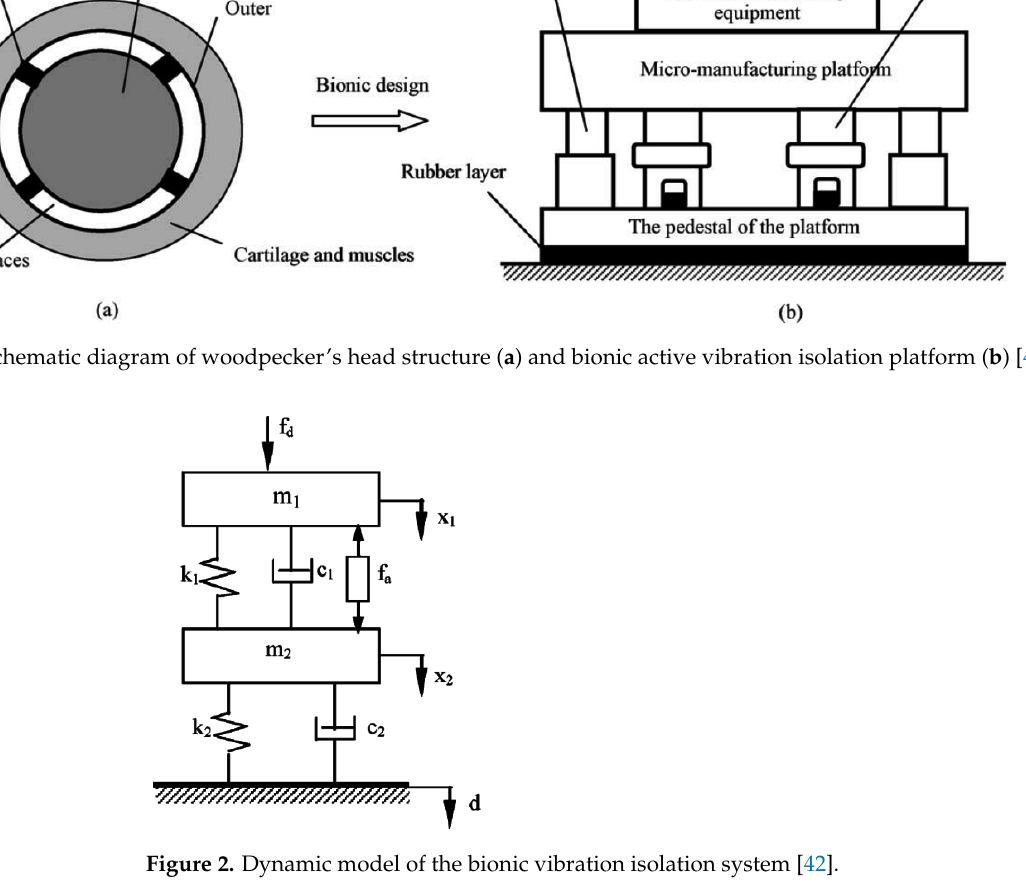
Figure 2. Dynamic model of the bionic vibration isolation system [42].